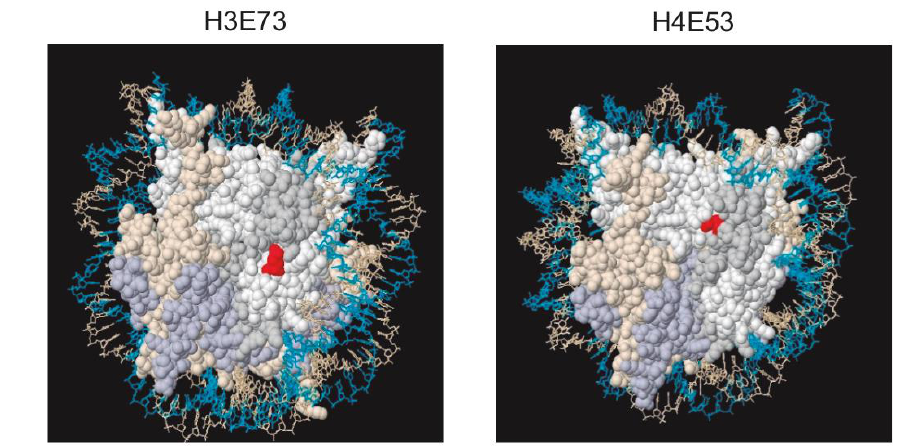
FIGURE 5: Location of H3E73Q and H4E53A mutations. 3D view of the nucleosome crystal structure of the yeast nucleo- somes with H3E73 and H4E53 residues colored in red. The images were obtained